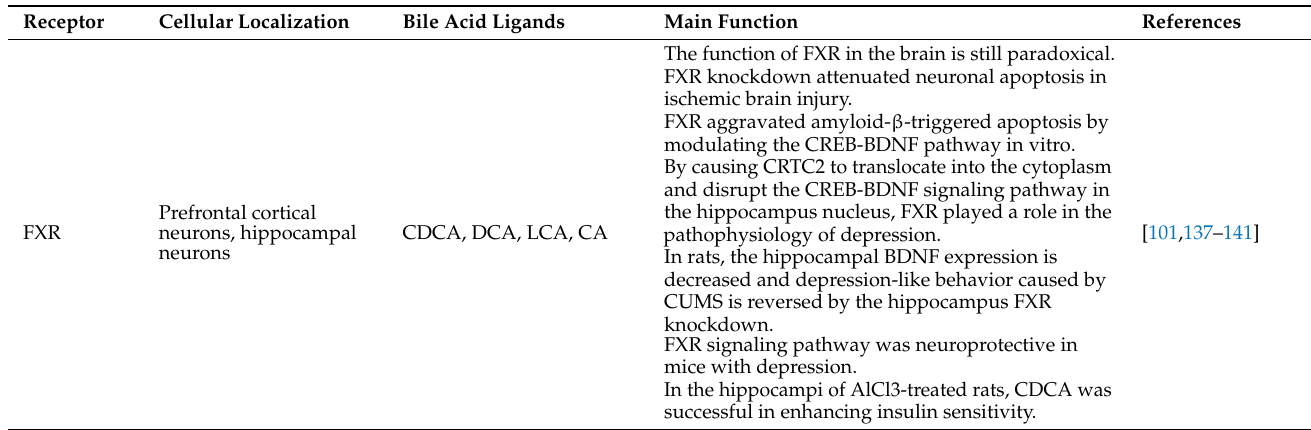
Table 1. Bile acid receptors found in the